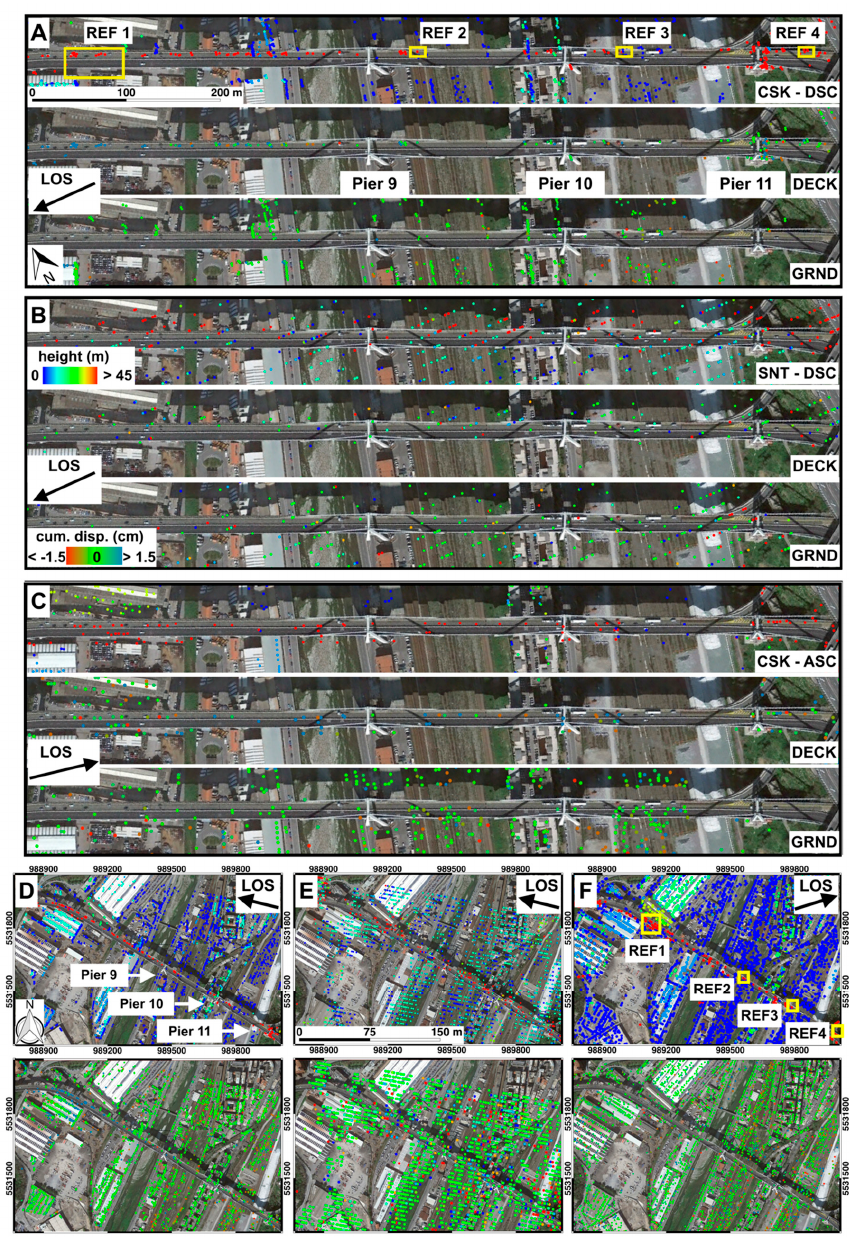
Figure 4. COSMO-SkyMed (CSK) and Sentinel-1A / B (SNT) multi-temporal Interferometric SAR analysis of the Morandi Bridge. ( A ) CSK descending dataset: (top) persistent scatterers (PS) height (center) PS deck level cumulative LOS displacements spanning 2009–2018; (bottom) LOS displacements for points located on the ground spanning 2009–2018. ( B ) SNT descending dataset: (top) persistent scatterers height; (center) PS deck level cumulative LOS displacements spanning 2015–2018; (bottom) LOS displacements for points located on the ground spanning 2015–2018. ( C ) CSK ascending dataset: (top) persistent scatterers height; (center) PS deck level cumulative LOS displacements spanning 2011–2018; (bottom) LOS displacements for points located on the ground spanning 2011–2018. (D ) Zoom out of the CSK descending dataset spanning 2009–2018: (top) persistent scatterers height; (bottom) Cumulative LOS displacements. ( E ) Zoom out of the SNT descending dataset spanning 2015–2018: (top) persistent scatterers height; (bottom) Cumulative LOS displacements. ( F ) Zoom out of the CSK ascending dataset spanning 2011–2018: (top) persistent scatterers height; (bottom) Cumulative LOS displacements. All PS height and cumulative displacements maps share the same scale as shown in panel B. Panels A, B and C are rotated and aligned with the bridge east–west extension. All panels are in georeferenced WGS84 coordinate